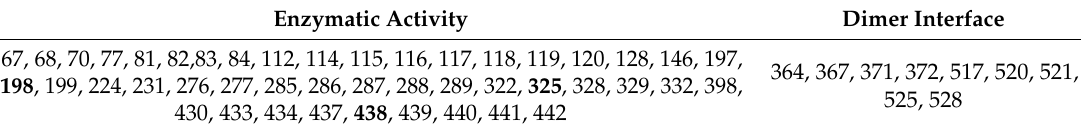
Table 1. Conserved residues selected during the Protein Repair One Stop Shop (PROSS) process in order to preserve both enzymatic activity and dimer interface. Residues of the catalytic triad are represented in bold. Positions are numbered from the physiologically maturated